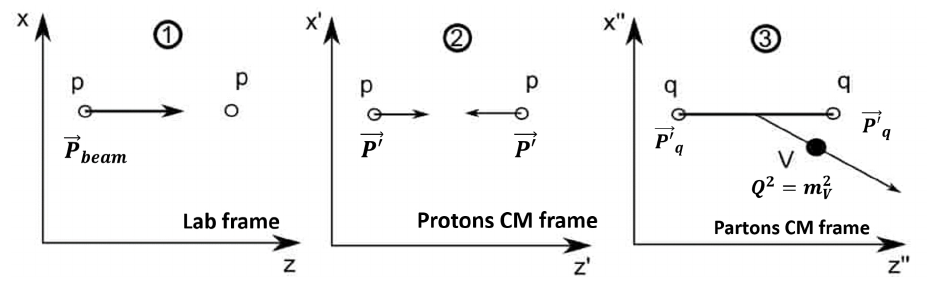
Figure 2. Proton-proton collisions in the target shown in three different reference systems.